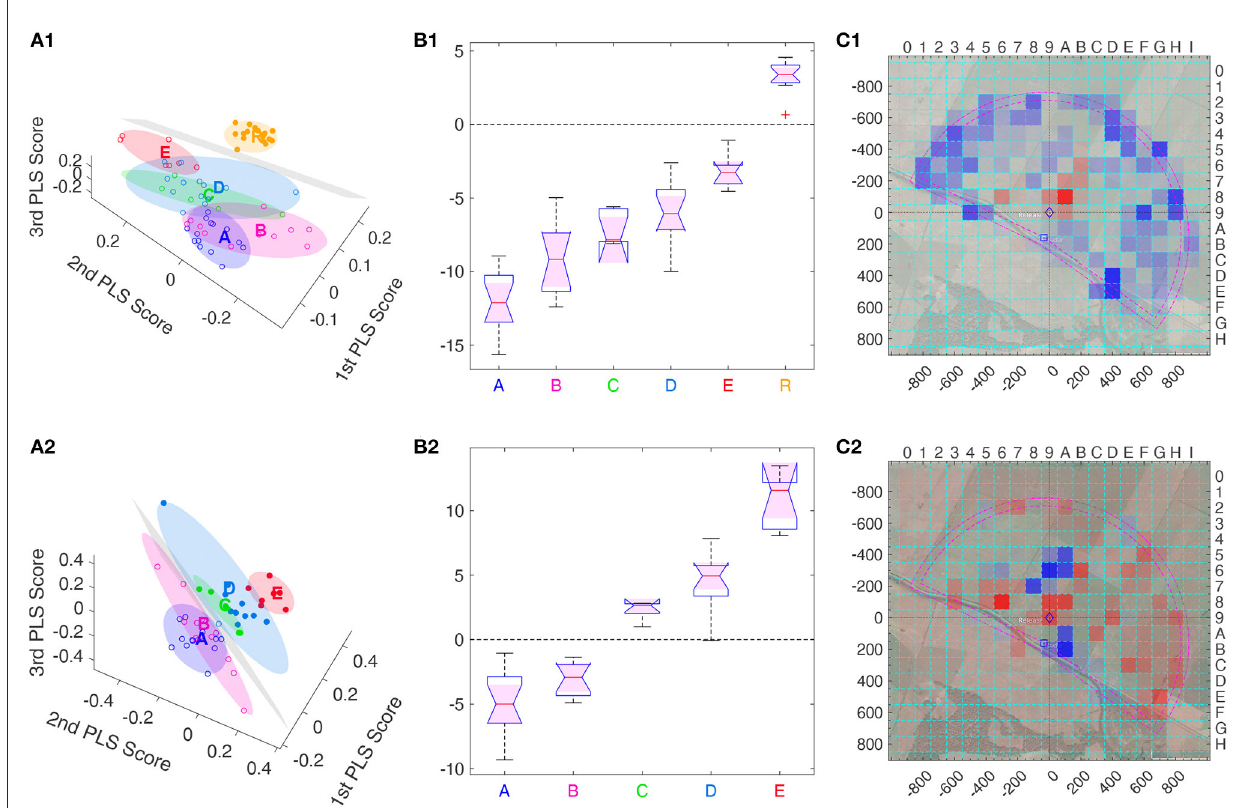
FIGURE7 Separatrices, obtained using support vector machines (SVM), of the three main PLS components. (A1–C1) (first row) Hyperplane separating R bees from all other groups, with PLS that ignored S group. (A2–C2) (second row) Hyperplane separating the A and B group from the C, D, and E groups, in the space of the three dominant PLS support vectors where both R and S group were ignored. (A1, A2) (first column) 3D view of each bee’s heatmap projected onto the three main PLS support vectors ( or ), together with a minimum volume ellipsoid containing all bees of one group (color code ◦ • for points and ellipsoids: A, B, C, D, E, and model group R) as well as the separating hyperplane (in gray). All bees on one side (positive side) of the hyperplane are marked , those on the other side (negative side) by . (B1, B2) (second column) Distribution of the signed distance of each bee to the • ◦ separating hyperplane within each group, with the separatrix marked by the dashed line at distance zero. Positive distance corresponds to points above the hyperplane and are denoted by in the 3D views (A1, A2) , while points below have a negative distance and are marked by . In both cases, • ◦ the distance to the separatrix allows for discriminating each pair of groups with significance level ***, i.e., a 1 mes 0.4, except for the pair C vs. D in ≥ (B1) with **, due to 1 mes 0.35. (C1, C2) (third column) Separating hyperplanes viewed as heat maps, color coded as in Figure 6B. Significance = levels: *** ∆ mes 0.4, ** ∆ mes ≥ ≥